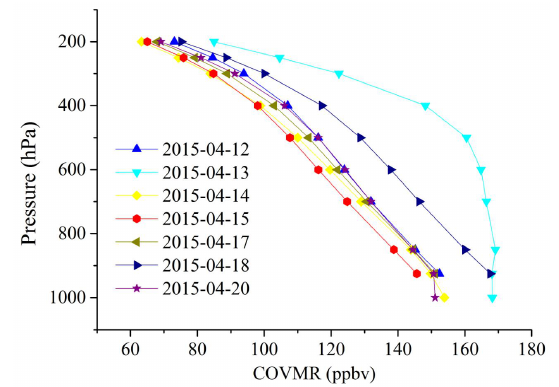
Figure 10. CO volume mixing ratio (COVMR) during dusty and non-dusty days. The red line represents profile during the dusty day.